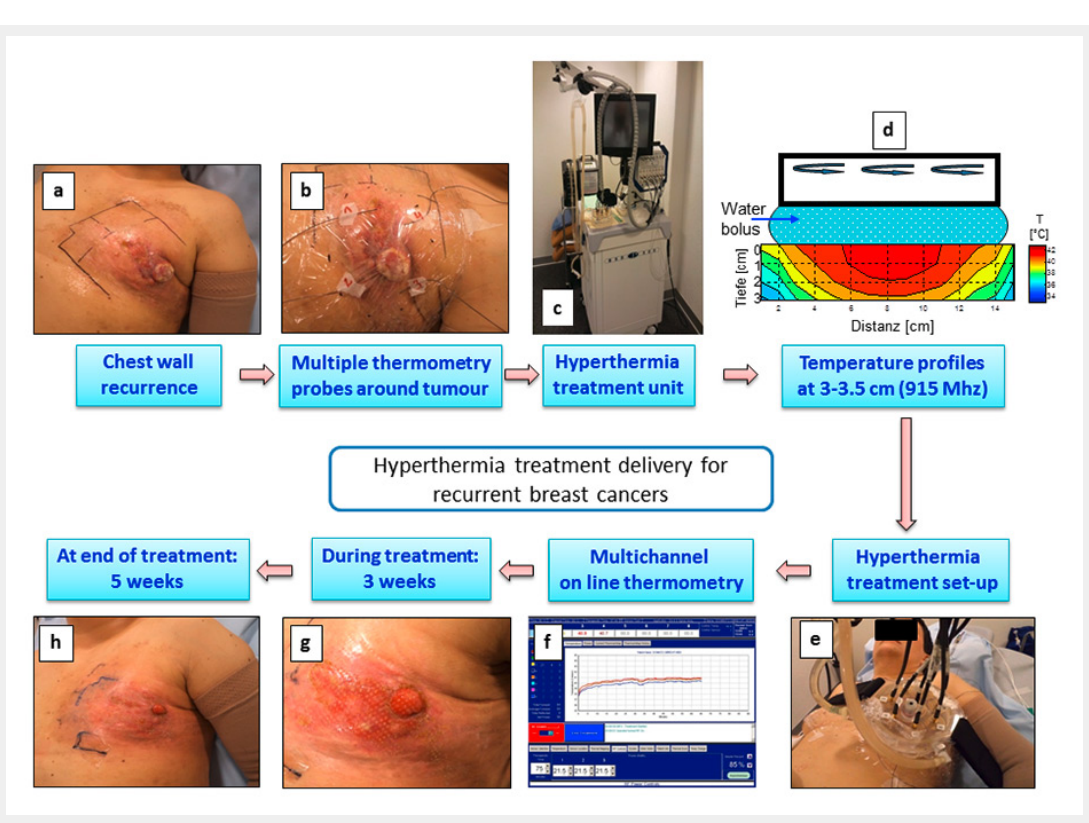
Steps involved in the hyperthermia treatment delivery for a patient with locoregional recurrent breast cancers. (a) Patient with the chest wall recurrence following previous radiotherapy. (b) Placement of multiple thermometry sensors all around the tumour in the area to be treated with hyperthermia. (c) Superficial hyperthermia treatment unit (BSD 500, 915 MHz). (d) Temperature profiles in a phantom showing the heating patterns with 915 MHz radiofrequency applicators. A water bolus has been sandwiched between the applicators and the phantoms to simulate the treatment conditions. A temperature ranging from 40–43 °C could be achieved to a depth of 3 cm. (e) and (f) Actual treatment setup with online recording of the temperature profiles. (g) and (h) Tumour regression observed at 3 weeks and at completion of treatment with minimal skin morbidity. The patient went on to achieve a complete response at 6 weeks of completion of reirradiation and hyperthermia.